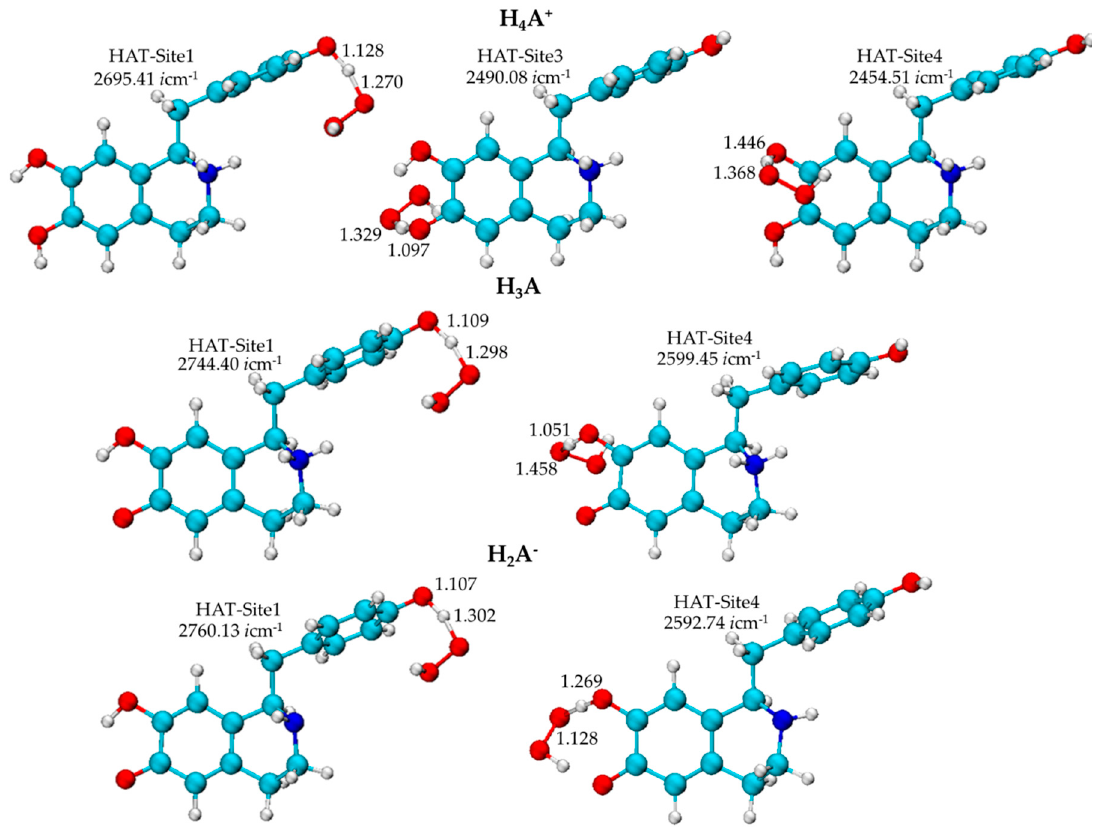
Figure 4. Geometries of the transition states of the H 4 A + , H 3 A, and H 2 A − forms obtained in water as a result of hydrogen atom transfer mechanism at the M062X/6-311+G(d) level of theory.